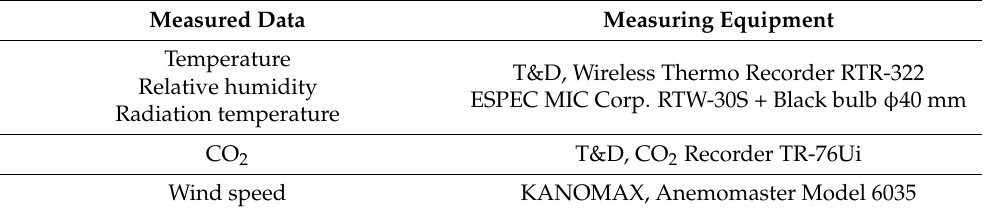
Table 1. The details of the measuring